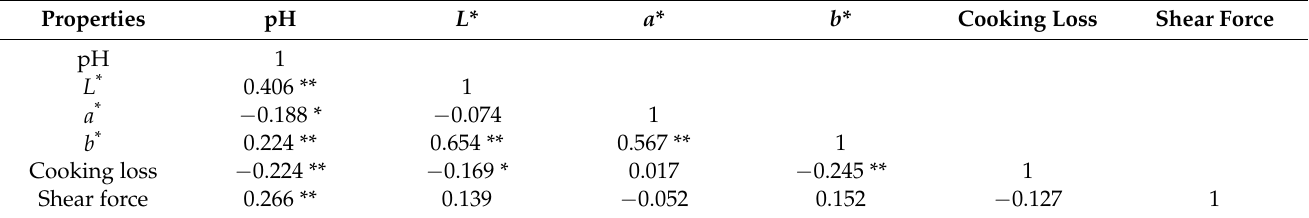
Table 2. Correlations between the six physicochemical properties of the combined meat cut